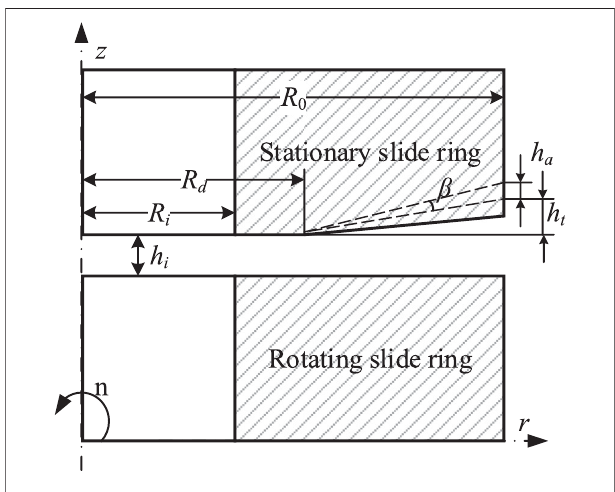
FIGURE 1 | The geometry of the mechanical seal.